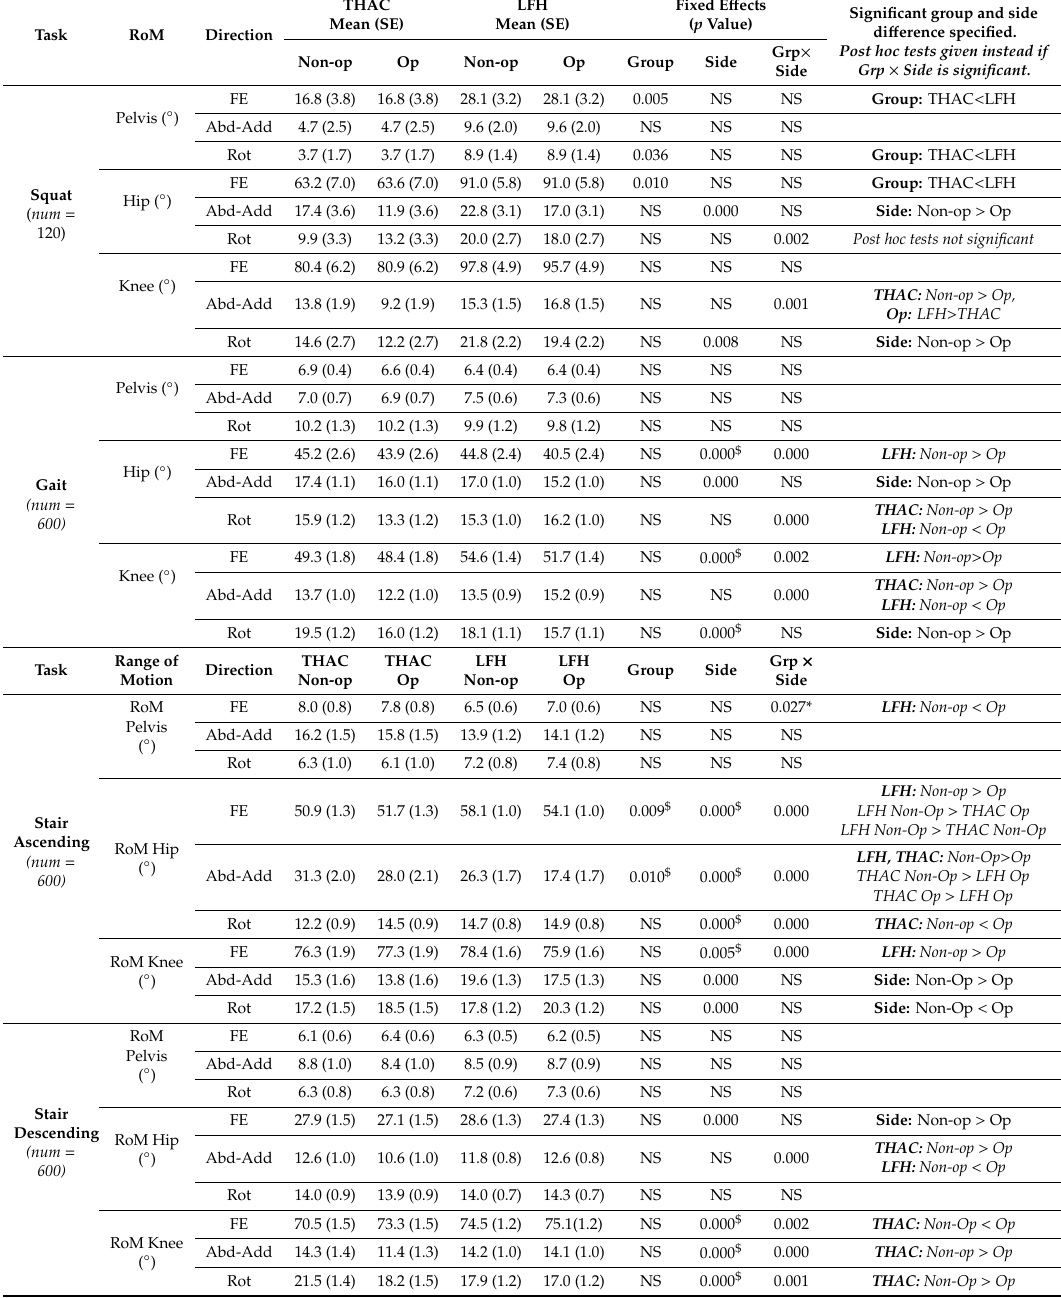
Table 4. Adjusted marginal means (Mean) and standard errors (SE) for range of motion (RoM) in non-operated and operated legs in the conventional hip replacement group (THAC) and the large femoral head (LFH) design group. “FE” = Flexion-extension; “Abd-Add” = Abduction-adduction; “Rot” = inward-outward rotation and “ num ” = the number of observations (Squat: 15 participants × 4 cycles × 2 legs; Gait and Stair ascending / descending: 15 participants x 5 trials × 4 cycles × 2 legs). The significance level p is reported for significant fixed e ff ects and interactions (Group, Side, Group × Side); “NS” = non-significance. Post hoc tests were performed if a significant interaction was found. The notation “$” denotes misleading significance due to involvement in